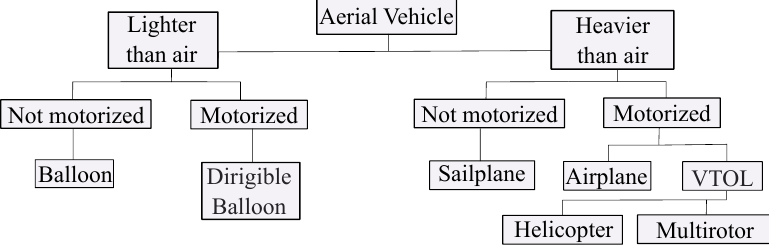
Figure 1. Aerial vehicles classification. This work is focused on